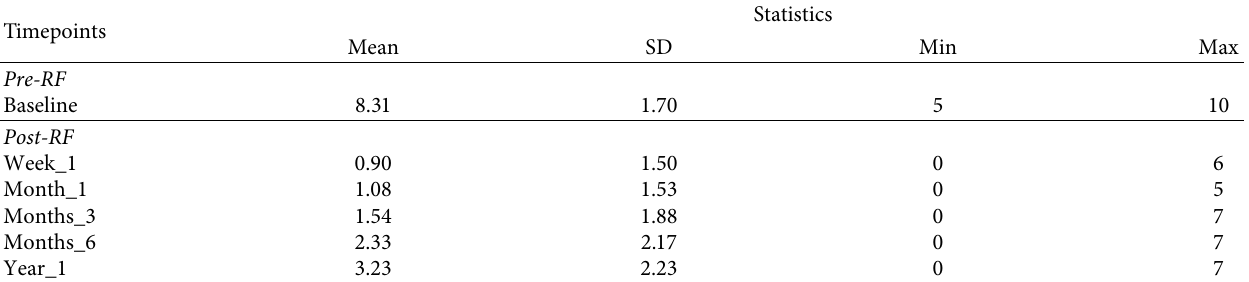
Table 2: Descriptive statistics of NVS questionnaire in the total group of 39 cases at different timepoints.